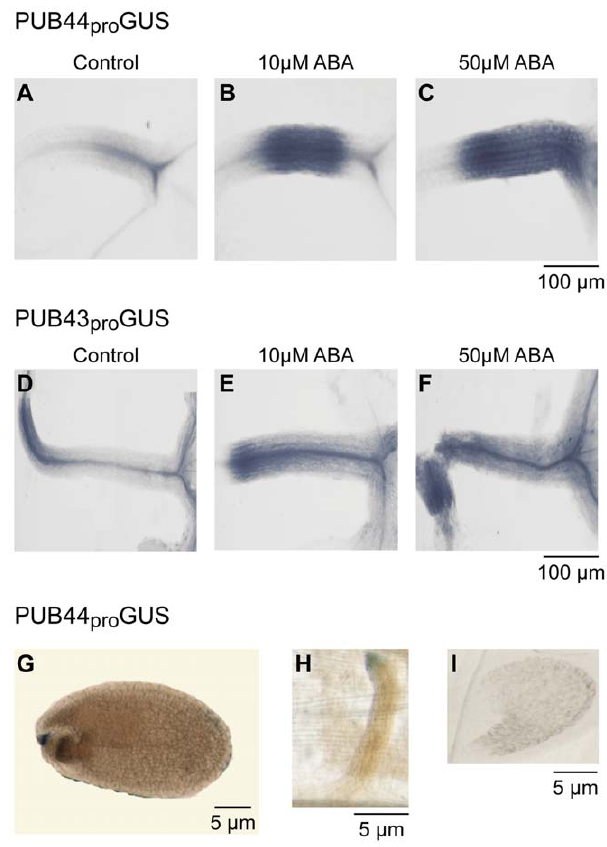
Figure 3. GUS activity staining of PUB44 pro GUS and PUB43- pro GUS transgenic plants. ( A – F ) GUS activity following treatment of 7 day old seedlings with ABA. Seedlings were treated with 10 m M ABA or 50 m M ABA for 2 hours. Images of the hypocotyls are shown. A minimum of 10 seedlings and 3 replicate experiments were analyzed, and representative images are shown. ( G – H ) GUS activity in seeds from PUB44 pro GUS transgenic plants. G seed, H funiculus, and I embryo. Scale bars represent distances as